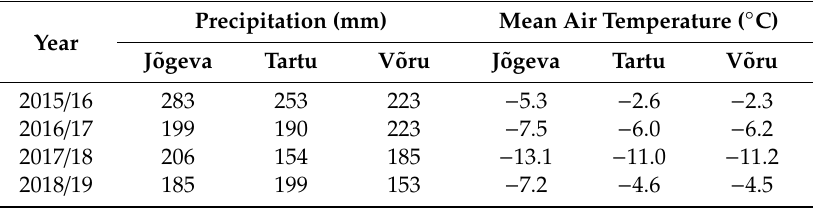
Table 1. Wintertime (November–March) precipitation and mean air temperature. Based on data from J õ geva (corresponding to Laiuse study site), Tartu Observatory (corresponding to the Norway spruce and the Downy birch site) and V õ ru (corresponding to Ess-soo site) weather